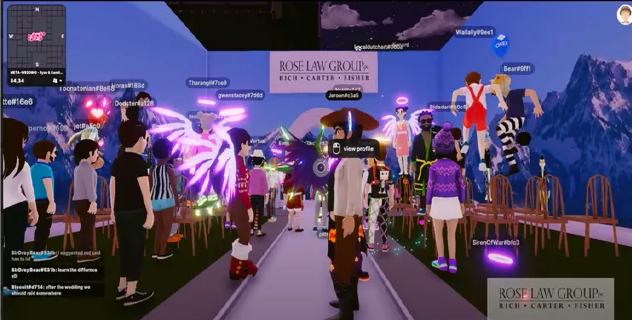
Figure 27: Candice and Ryan Hurley’s wedding in the metaverse